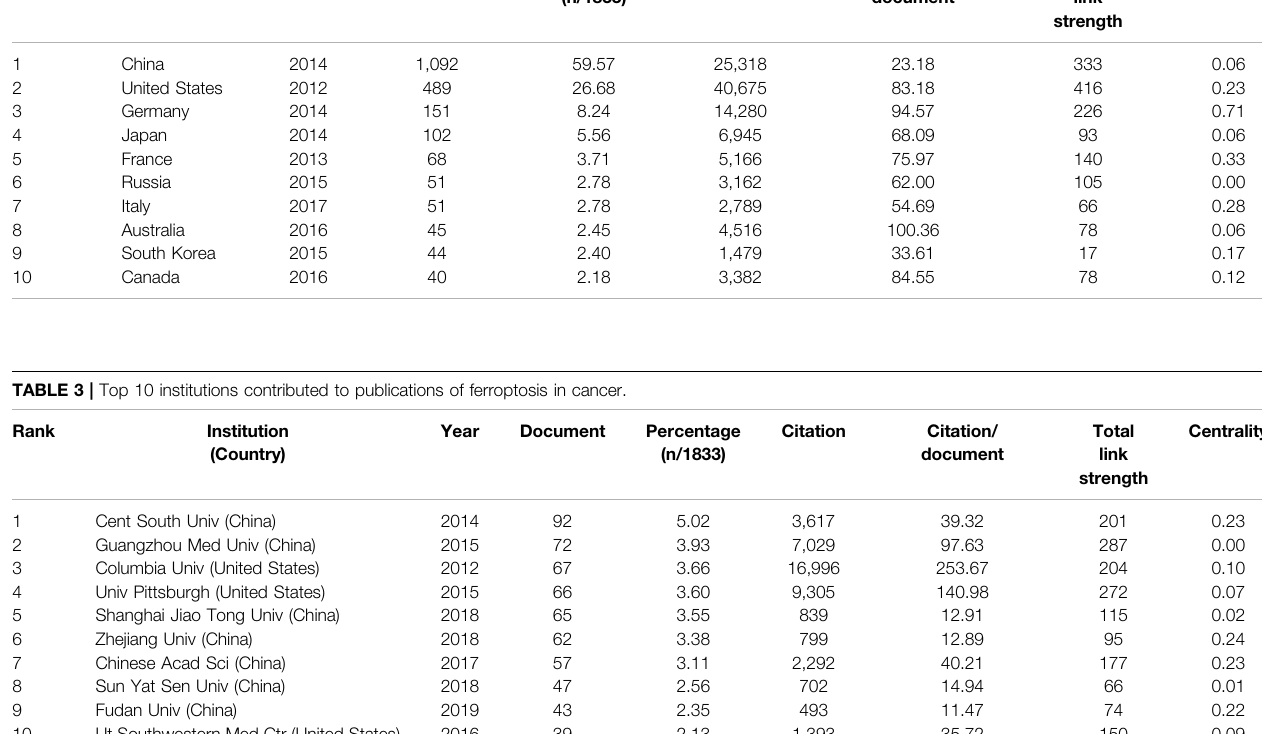
TABLE 2 | Top 10 countries contributed to publications of ferroptosis in cancer. Rank